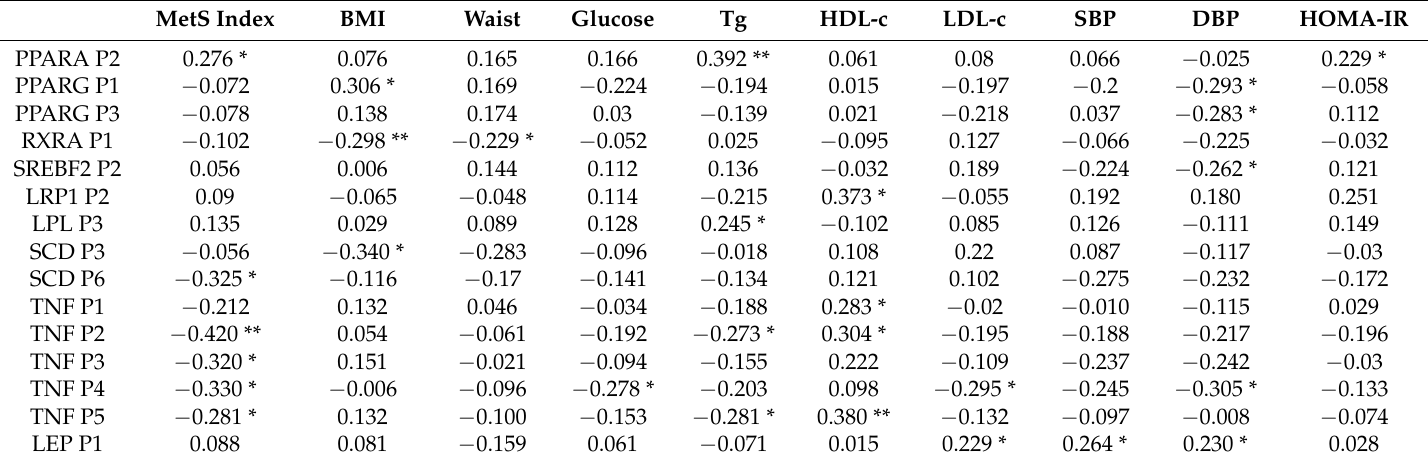
Table 4. Correlation analyses between anthropometric and biochemical variables associated to MetS with some of the DNA methylation at the CpG islands (CpGi) analyzed. Only CpG that presented any significant association are